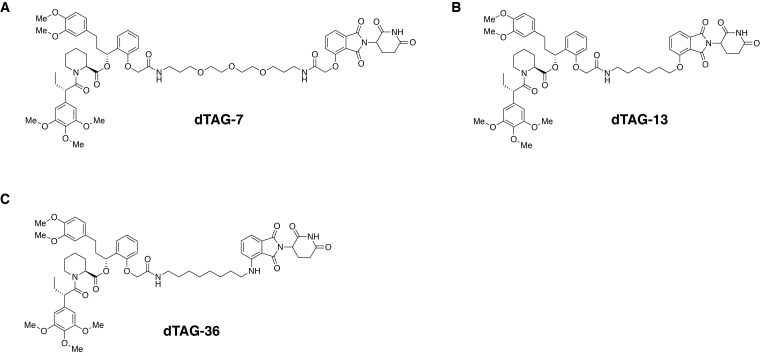
Chemical structures of dTAG molecules.FKBP12F36V-binding ligands conjugated by variable linkers to thalidomide or pomalidomide, including (A) dTAG-7, (B) dTAG-13 and (C) dTAG-36 are capable of inducing degradation of FKBP12F36V-tagged proteins of interest.